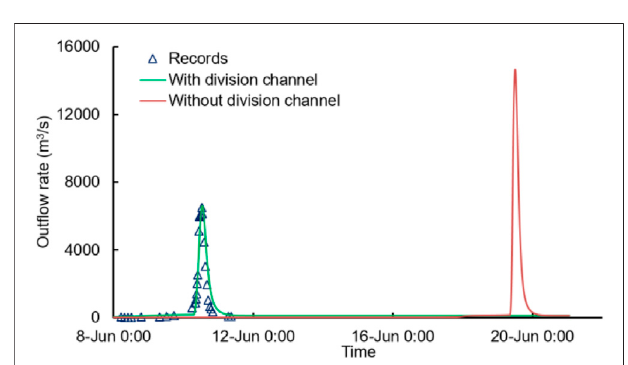
FIGURE 7 | The breaching out fl ow rates of the real case and two simulated